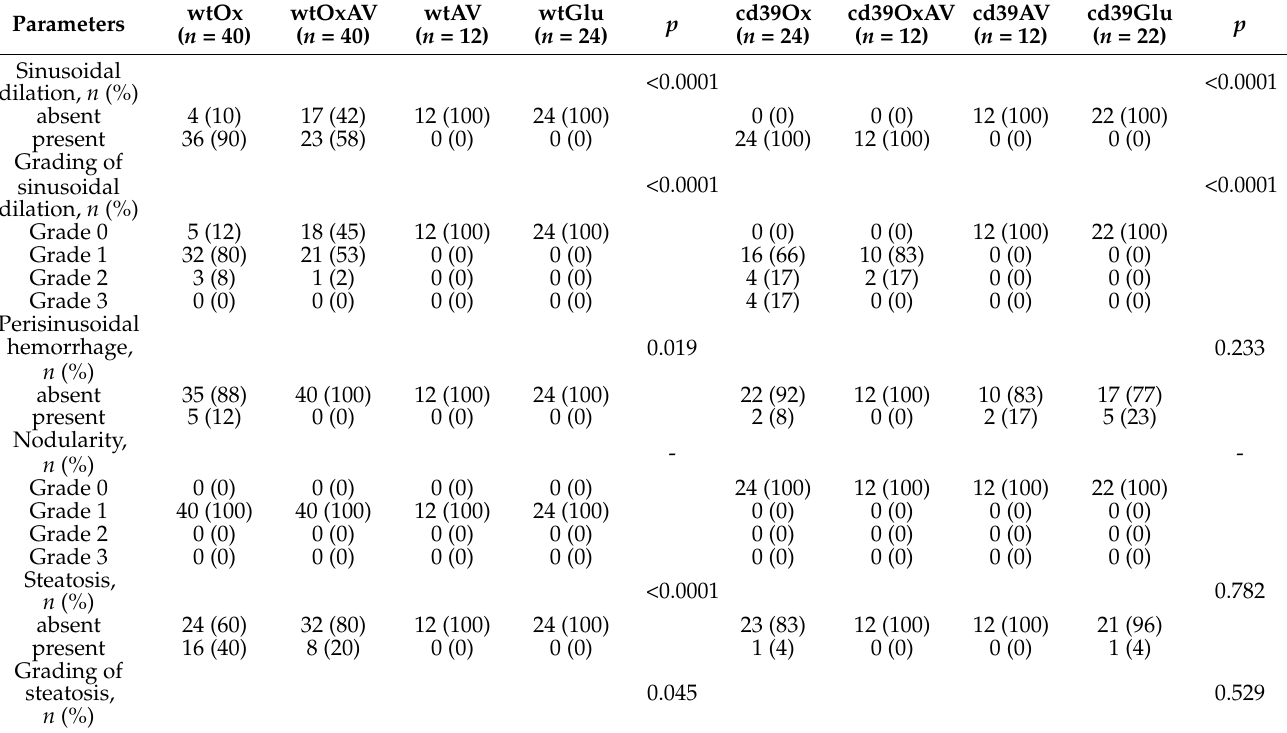
Figure 2. Histopathological analysis. ( A ) Characteristic H&E slides of liver tissue of wt and CD39-null mice after treatment with oxaliplatin or oxaliplatin and anti-VEGF: The typical sinusoidal dilation around the central veins is visible in all groups except wtOxAV. Magnification 20 × . ( B ) Development of sinusoidal dilation as evaluated by H&E slides: Sinusoidal dilation was found in 90% and 58% in the wtOx and wtOxAV group, respectively (***, p = 0.001). In contrast, all CD39-null mice treated with oxaliplatin or oxaliplatin and anti-VEGF developed sinusoidal dilation. Hence, anti-VEGF did not protect against the development of sinusoidal dilation in CD39-null mice receiving oxaliplatin compared to wtOxAV (100% vs. 58%, p = 0.005). Table 1. Histopathological analysis of liver tissue of wt and CD39-null mice after five weeks of treatment, according to Rubbia-Brandt et al. [2].